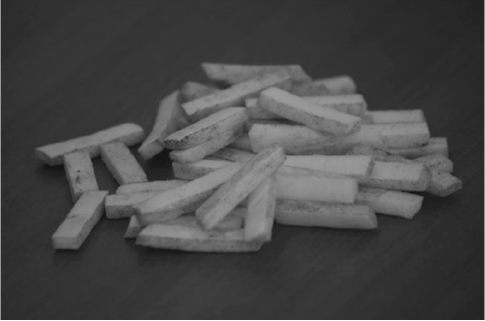
Figure 3. Floating carrier Polystyrene.